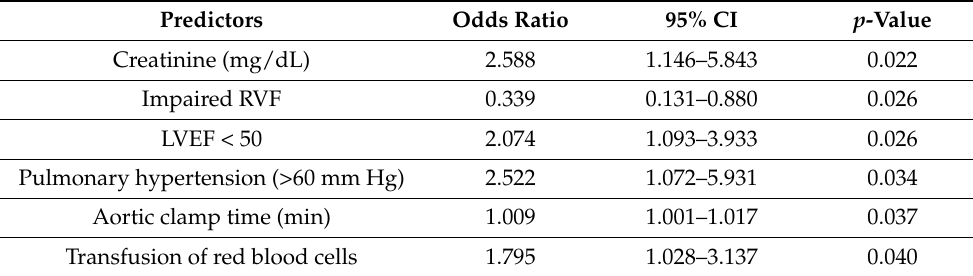
Table 4. Logistic regression analysis for the occurrence of UPE after MIC.